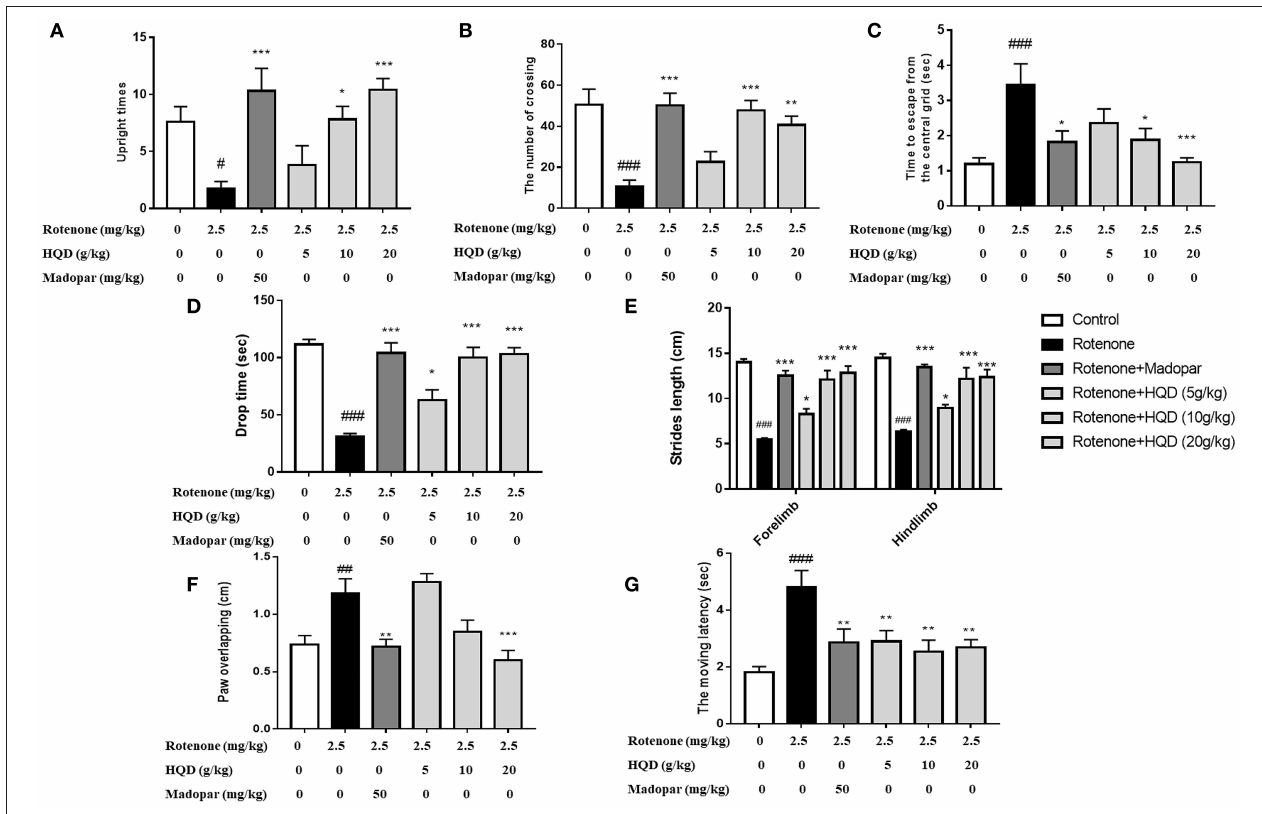
FIGURE 3 | The improvement effects of HQD on motor coordination abilities of rotenone-induced PD rats. (A) Upright times in open field. (B) The number of crossing in open field. (C) Time to escape from the central grid in open field. (D) Drop time from the rotating rod. (E) Strides length in gait experiment. (F) Paw of overlapping in gait experiment. (G) The moving latency in grid experiment. # P < 0.05, ## P < 0.01, ### P < 0.001 vs. control group; * P < 0.05, ** P < 0.01, *** P < 0.001 vs. rotenone group ( n =